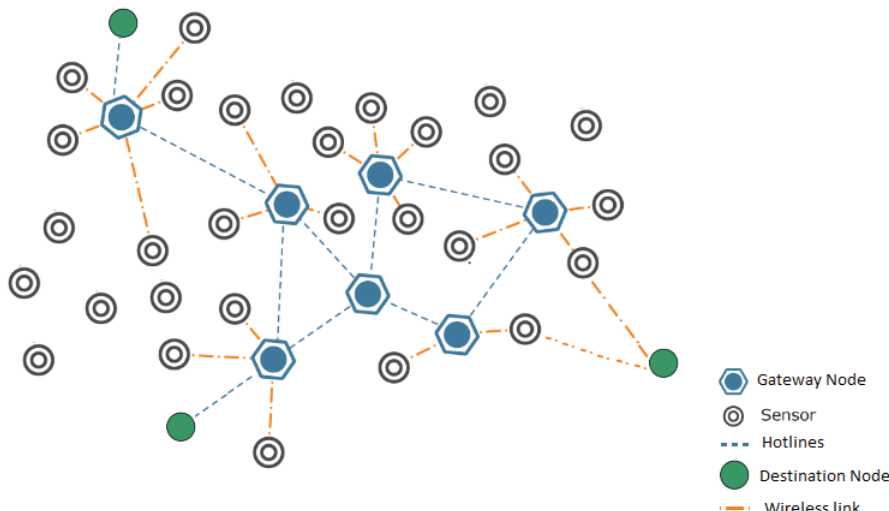
Figure 2. WSN with Hotlines